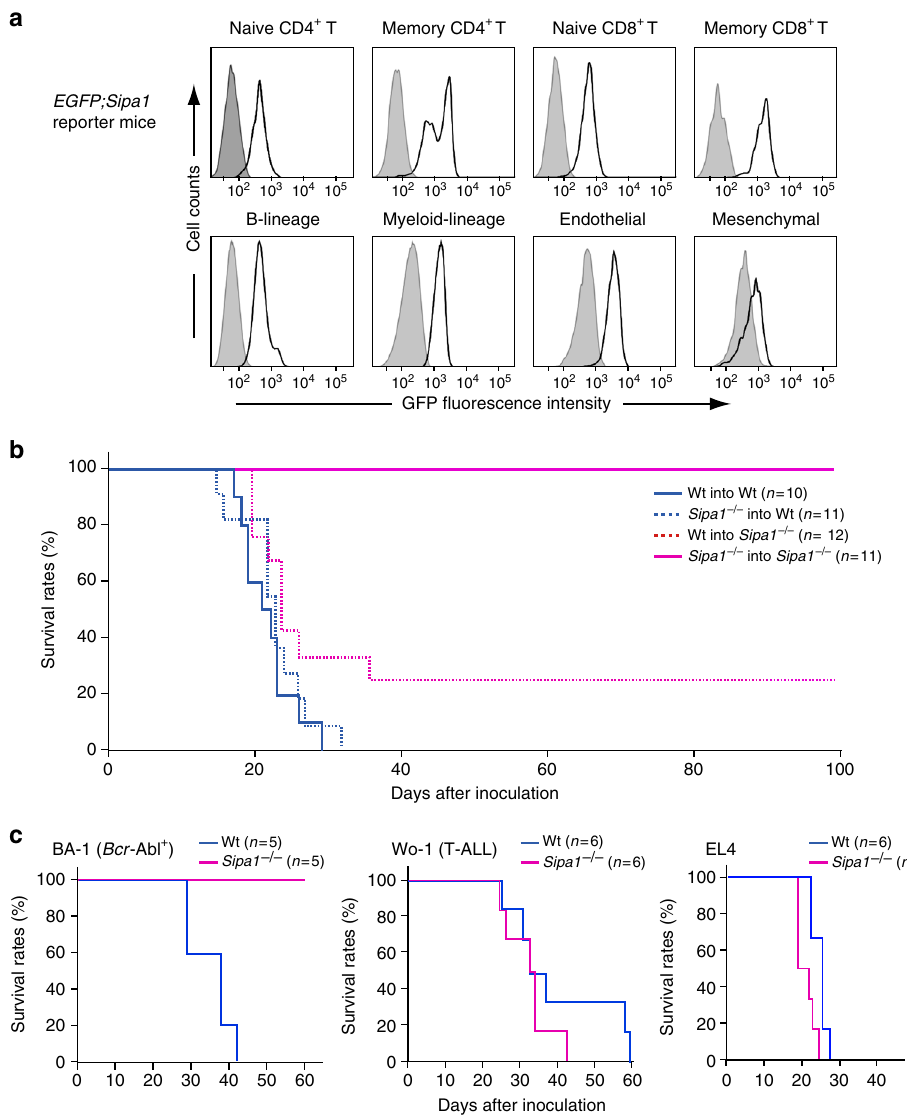
Fig. 3 CML resistance of Sipa1 − / − mice requires both hematopoietic and non-hematopoietic cells. a Expression of GFP in the BM cells of EGFP; Sipa1 reporter mice was analyzed with FACS at the gates of CD3 + CD44 low CD62L high CD4 + (naive CD4 T), CD3 + CD44 high CD62L low CD4 + (memory CD4 T), CD3 + CD44 low CD62L high CD8 + (naive CD8 T), CD3 + CD44 high CD62L low CD8 + (memory CD8 T), CD45 + B220 + (B-lineage), CD45 + CD11b + (Myeloid), CD45 − Ter119 – CD31 + (Endothelial), and CD45 – Ter119 – CD31 − PDGFR α + (Mesenchymal). Shaded regions indicate staining with isotype- matched control IgG. The intensities of GFP were con fi rmed to correlate with the intracellular Sipa1 expression levels. b BM chimeras between Wt and Sipa1 − / − mice were generated for all four donor/recipient combinations as indicated. At the intervals of 4 – 6 months after BMT, Bcr-Abl + HPCs of Wt mice were intravenously injected into the chimeric mice at 1.5× 10 4 cells per mouse. Survival curves of indicated numbers of recipients per group are shown. c Leukemia cell lines of B6 mice, BA-1 ( Bcr-Abl + CML), Wo-1 (T-ALL), and EL4 (T cell), were intravenously injected at 10 5 cells per mouse into Wt and Sipa1 − / − mice, and the survival rates were examined. Independent experiments were repeated for at least three times with similar